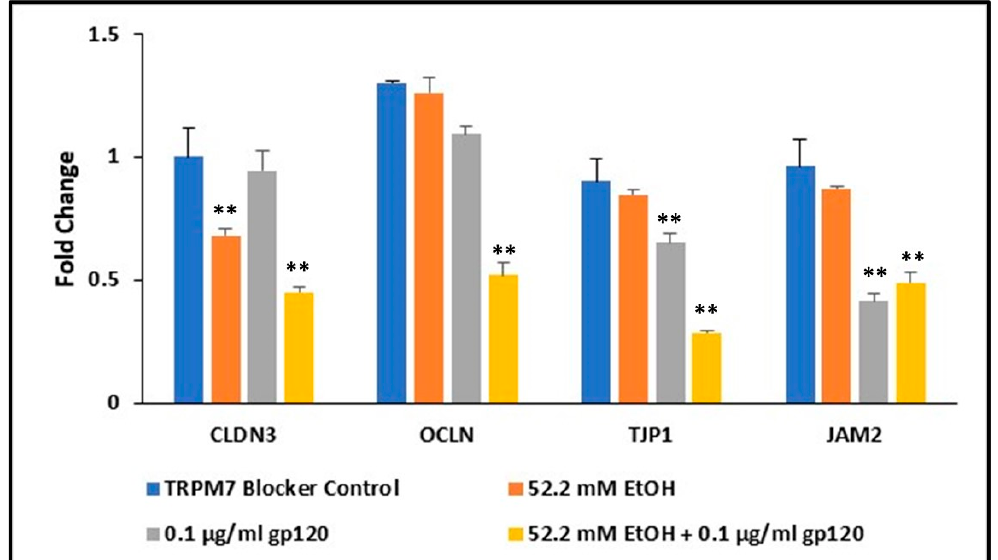
Figure 6. Fold change in various tight junction complexes gene expression in human BMVECs following 24 h treatment. ** p < 0.01. Int. J. Mol. Sci. 2023 , 24 , x FOR PEER REVIEW 2.8. Involvement of TRPM7 in Alcohol Induced Damage of the BBB in the Presence of HIV Viral Protein gp120